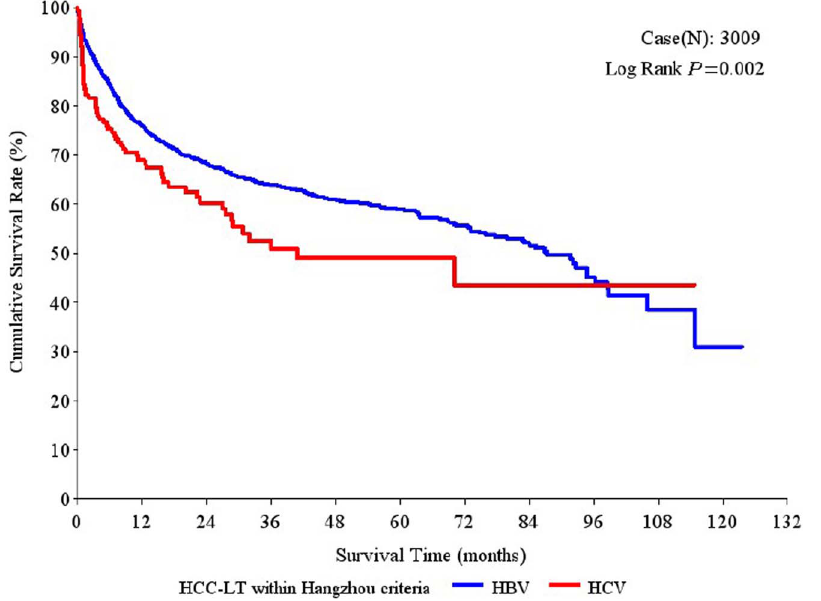
Figure 3. Tumor-free survival rates after liver transplantation (LT) in patients with hepatitis B virus (HBV)-associated hepatocellular carcinoma (HCC) and hepatitis C virus (HCV)-associated HCC who met the Hangzhou criteria.